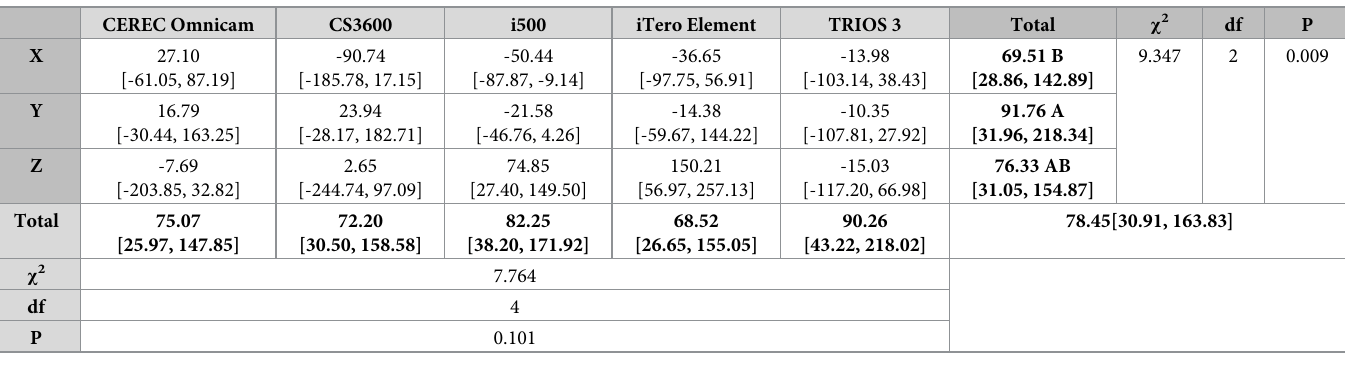
Table 3. Cumulative XYZ trueness values ( μ m) of